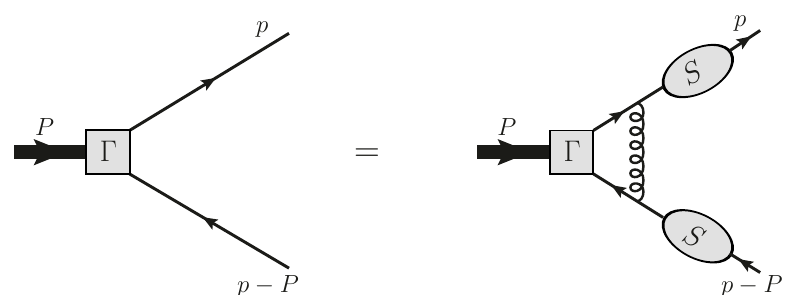
Figure 3 . Bethe-Salpeter equation for the meson-quark-antiquark